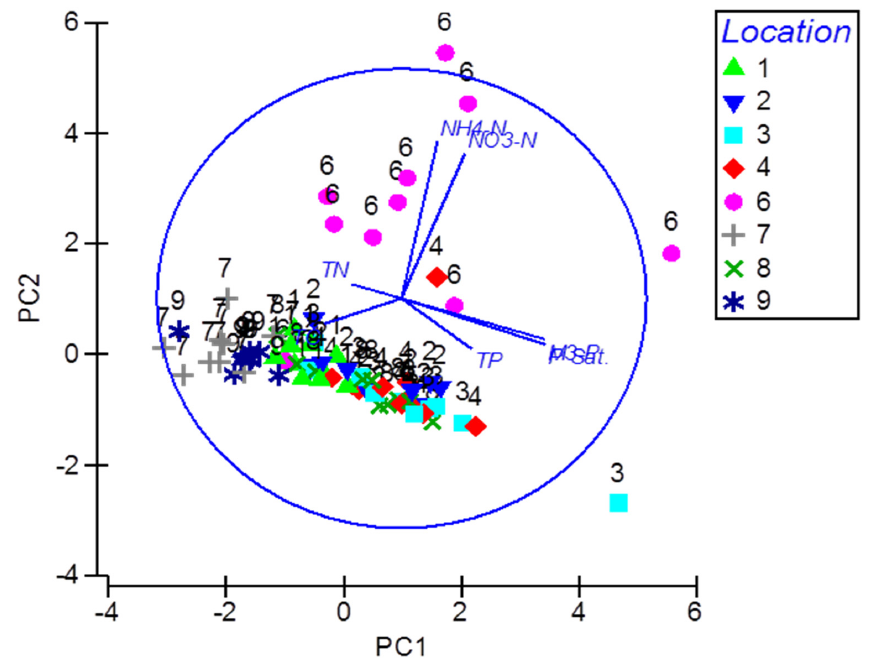
Figure 6. PCA plot for Site I soil samples without manure pile (sample 5).